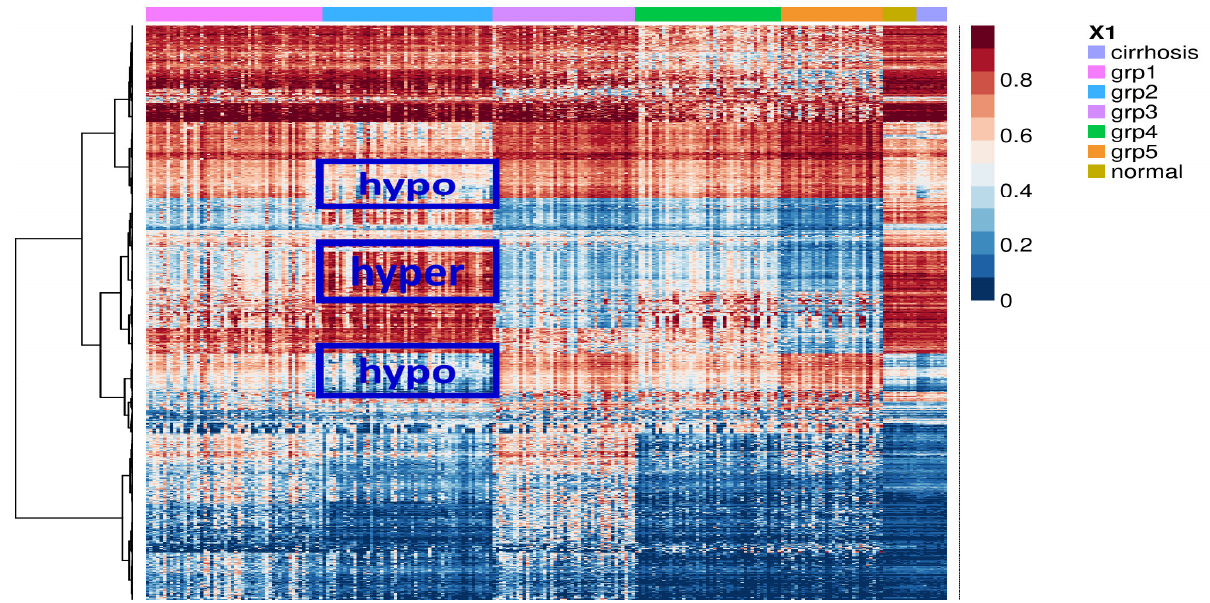
Figure 1. Heat map of DNA methylation at CpG sites in HCC, normal hepatocytes, and cirrhosis samples. Genome-wide DNA methylation data from 221 primary HCC samples [13] was used for NMF analysis to allow for the identification of potential subgroups. This analysis supported the existence of five putative methylation-based HCC subgroups. The figure shows clustering based upon the 10,000 most differentially methylated probes. Regions of methylation difference that are specific for subgroup-2 (versus the other four HCC clusters) are highlighted in blue boxes. G: Subgroup (1 to 5). N: normal hepatocytes. C: Cirrhosis.